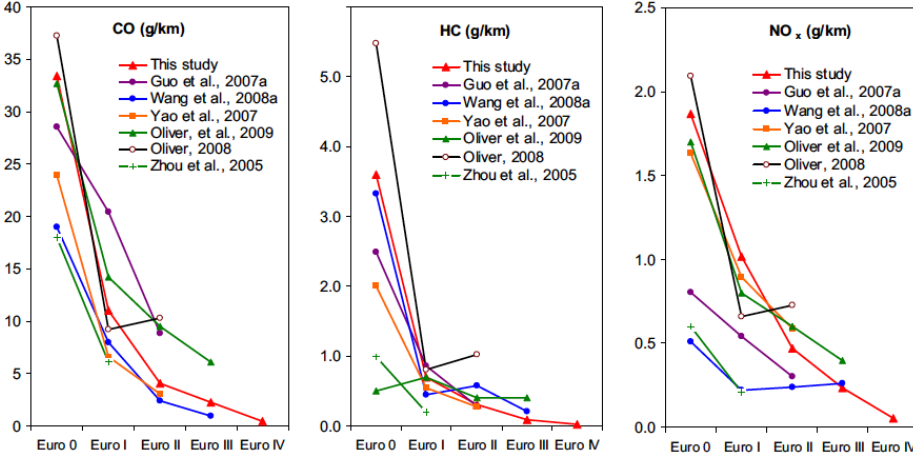
Figure 12. Comparison of emission factors of the LDGVs (light-duty goods vehicles) under real-world driving conditions from different studies showing the greater variation for older vehicles. Note that the emission measurement technologies are different among these studies (from Huo et al., 2012).